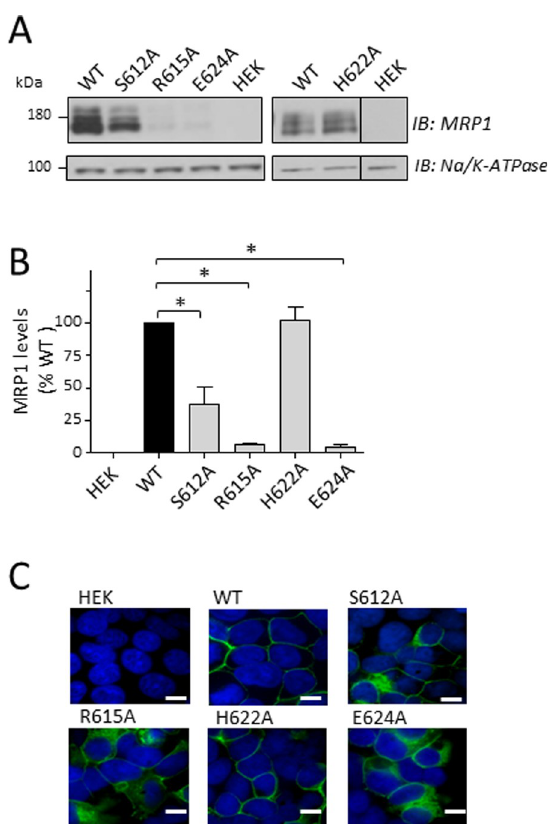
Fig 3. CR1 mutations S612A, R615A, H622A and E624A have different effects on total and membrane MRP1 levels in transfected HEK cells. (A) Shown are representative immunoblots of whole cell extracts (10 μ g protein loaded per lane) prepared from HEK cells transfected with wild-type (WT) and mutant (S612A, R615A, H622A, E624A) MRP1 pcDNA expression vectors as well as untransfected cells (HEK) (negative control). MRP1 was detected with mAb QCRL-1 [54], and anti-Na + /K + -ATPase served as a protein loading control. A vertical black line indicates where irrelevant lanes from the immunoblot were removed by cropping images; the vertical space between lanes indicates independent immunoblots. The images in each panel are from a single blot with the region between MRP1 and the loading control cropped out. (B) WT and S612A, R615A, H622A and E624A mutant MRP1 levels, normalized for protein loading based on the Na + /K + -ATPase signal, were estimated using densitometry and plotted as a percent of wild-type MRP1 levels. Bars represent the mean values ( ± SD) of results obtained from three independent transfections. � P < 0.05, unpaired t-test. (C) Shown are non-quantitative confocal microscopy images of HEK cells 24 h after transfection with WT and CR1 mutant (S612A, R615A, H622A, E624A) pcDNA expression vectors. MRP1 ( green ) was detected using rat mAb MRPr1 [56] and Alexa Fluor 488-conjugated goat anti-rat as the primary and secondary antibodies, respectively. Untransfected cells (HEK) were used as a negative control. Nuclei are stained blue . Signals from the two channels were acquired independently and the merged images are presented. White calibration bars ( bottom right ) represent 10 μ m.